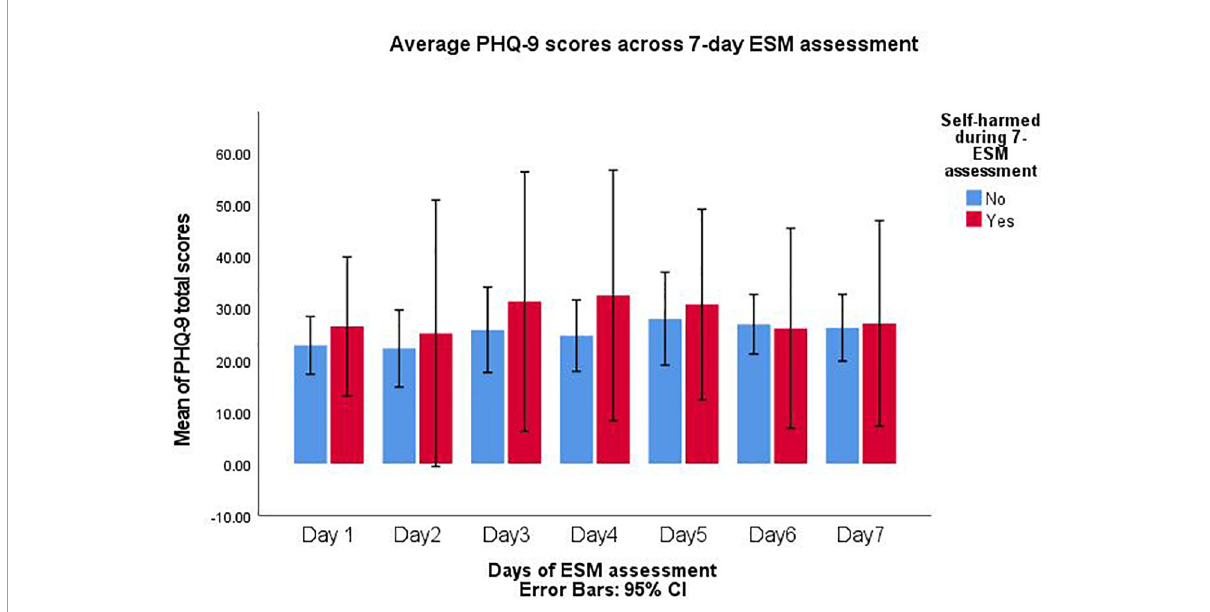
FIGURE2 PHQ-9 scores compared between participant who self-harmed and those who did not during 7-day experience sampling method (ESM) assessment.